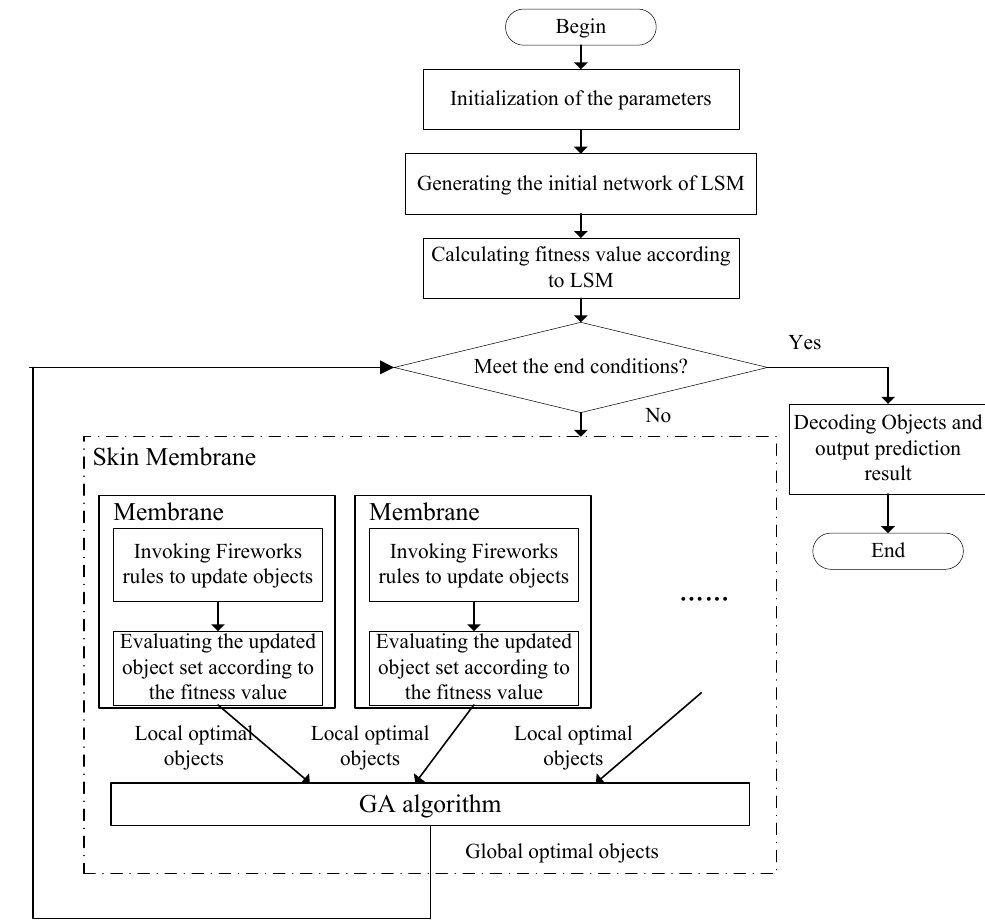
Figure 4. The flowchart of the proposed